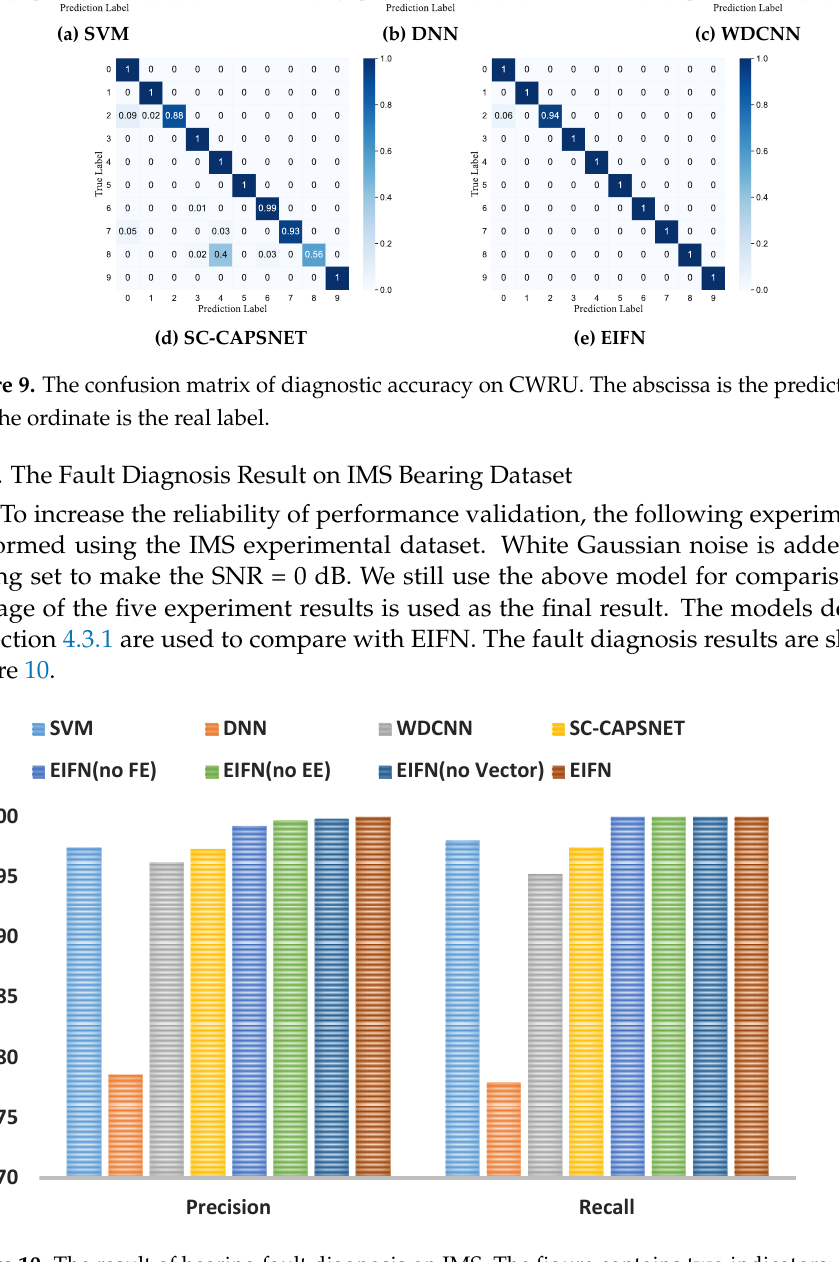
Figure 11. The confusion matrix of diagnostic accuracy on IMS. The abscissa is the prediction la- bel, and the ordinate is the real label. In Figure 11, EIFN achieves a recognition accuracy of 100% for the four states. SC- CAPSNET experiences a slight loss of accuracy in identifying the normal state with a la- bel of 0. The diagnostic accuracy of SVM is slightly better than that of WDCNN. DNN has a greater loss of accuracy in identifying normal state and inner ring fault. Based on the above experimental results, EIFN can still maintain a higher fault di- agnosis accuracy compared with other models when subjected to low-intensity noise. The fault diagnosis performances of EIFN on CWRU and IMS datasets verified the valid- ity of EIFN.